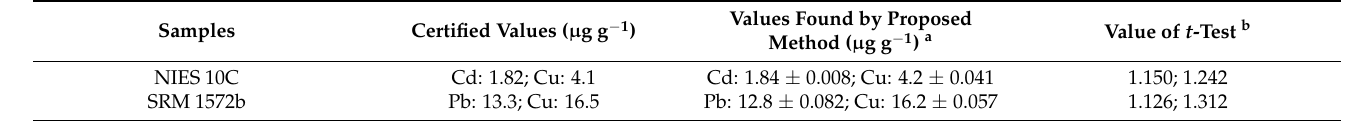
Table 4. Analytical method validation.